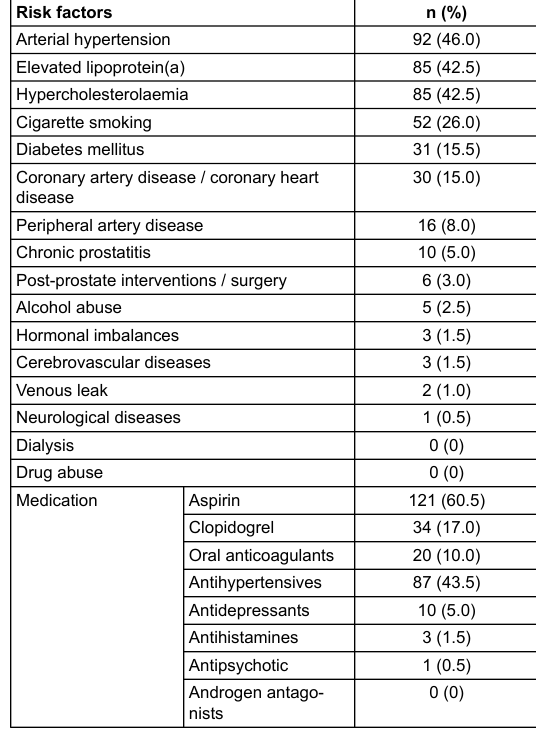
Table 1: Pre-existing risk factors, comorbidities and medication in 200 patients with erectile dysfunction.